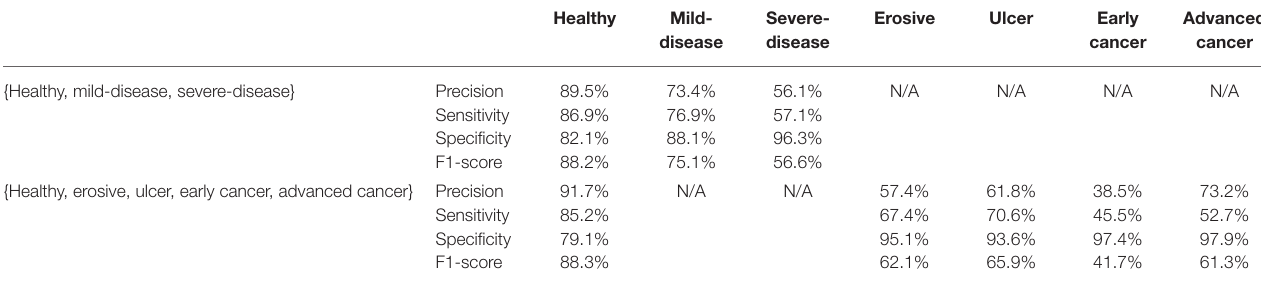
TABLE 2 | Precision, recall, F1-score of all multi-class classification experiments.